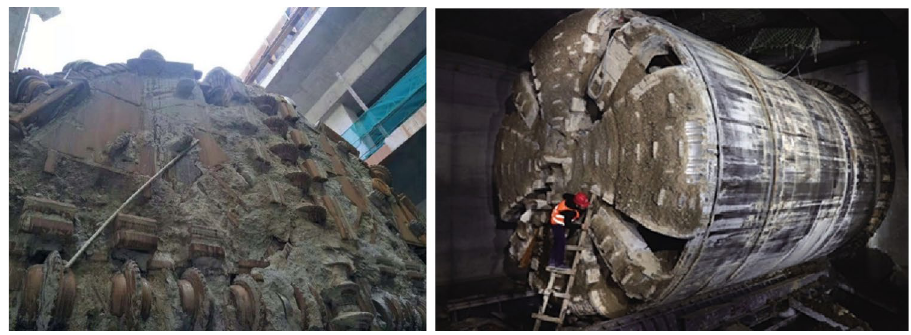
Figure 1. Mud cake at the